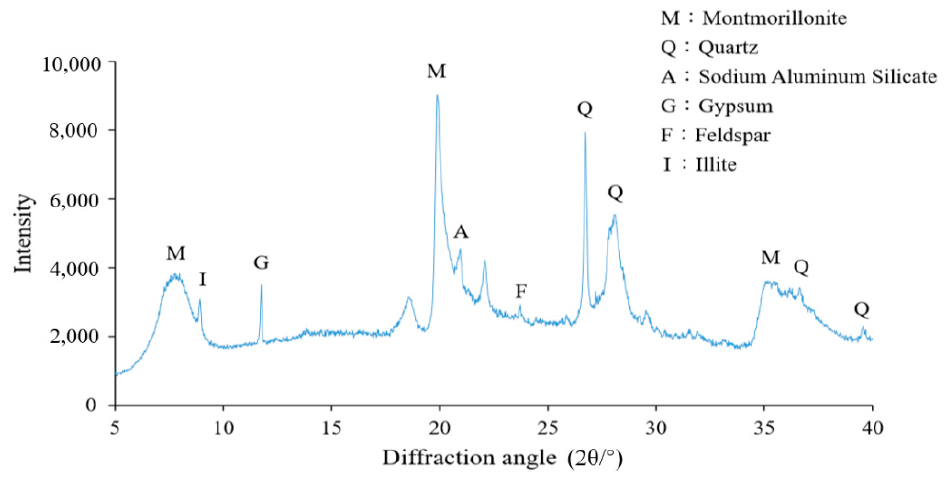
Figure 1. Powder X-ray diffractograms of the SPV200 bentonite.